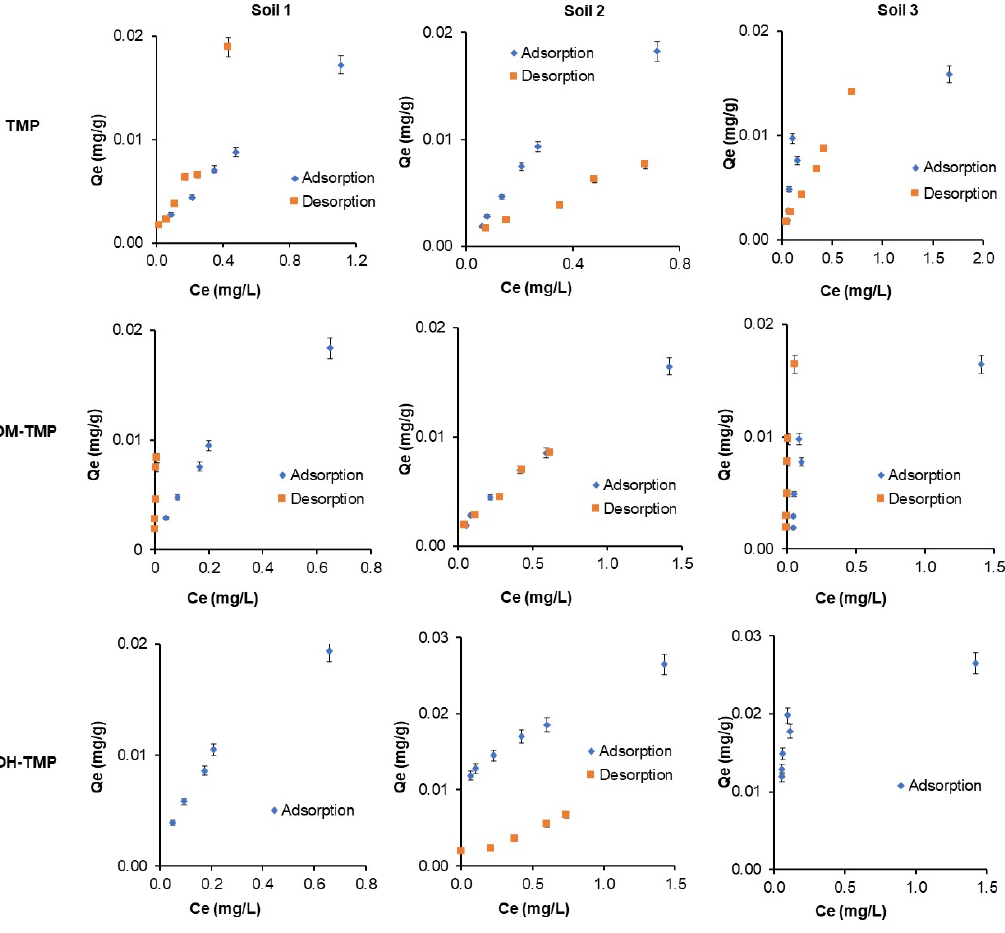
Figure 3. Adsorption and desorption isotherms of TMP and its metabolites in three Mediterranean